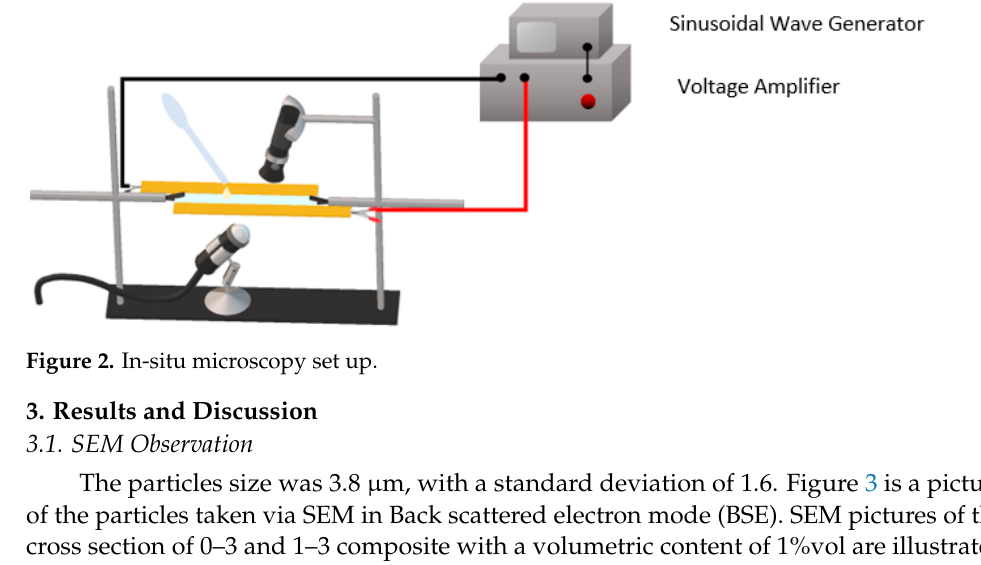
Figure 3. SEM picture, taken in back scattered electrons mode (BSE) of PZT fillers.